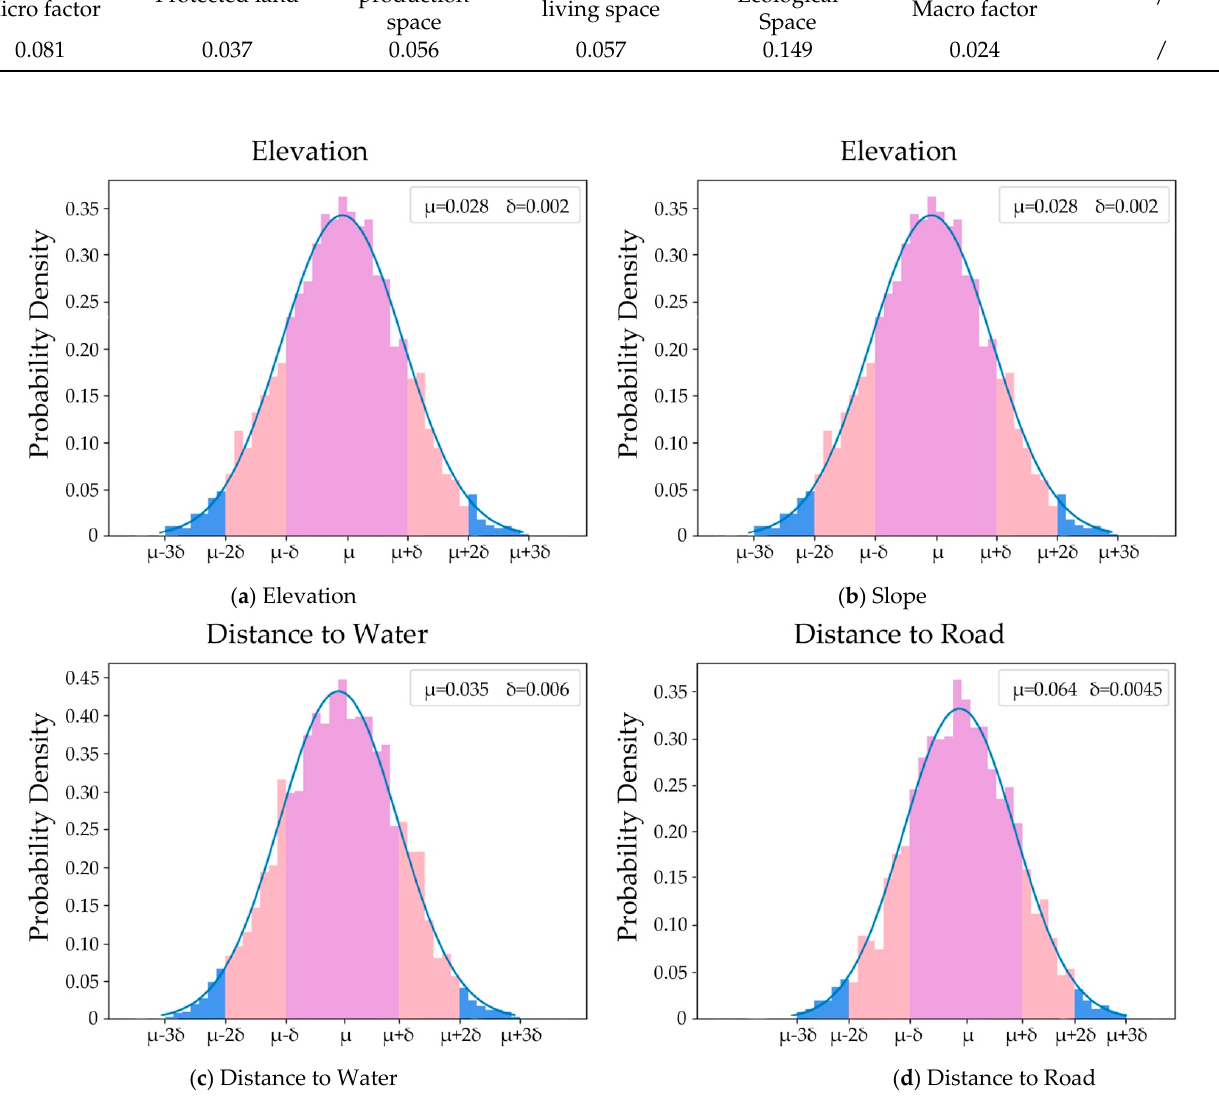
Figure 6. Error distributions of initial weight estimation of Elevation ( a ), Slope ( b ), Distance to Water ( c ) and Distance to Road ( d ) in living space evolution simulation.